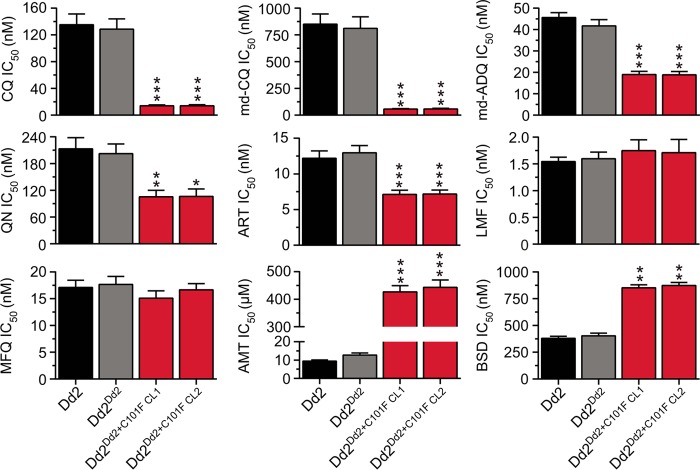
In vitro drug susceptibility of Dd2 recombinant lines to antimalarials. Mean ± SEM IC50s are shown for chloroquine (CQ), monodesethyl-chloroquine (md-CQ), monodesethyl-amodiaquine (md-ADQ), quinine (QN), artemisinin (ART), lumefantrine (LMF), mefloquine (MFQ), amantadine (AMT), and blasticidin (BSD). Data are represented in nanomolar concentration, except for those for AMT, which are expressed in micromolar concentration. (Values are listed in Table S1 in the supplemental material.) Data were obtained from 4 to 8 independent assays performed in duplicate. Statistical comparisons between Dd2Dd2+C101F clones and the isogenic control Dd2Dd2 used two-tailed Mann-Whitney U tests. *, P < 0.05; **, P < 0.01; ***, P < 0.001.